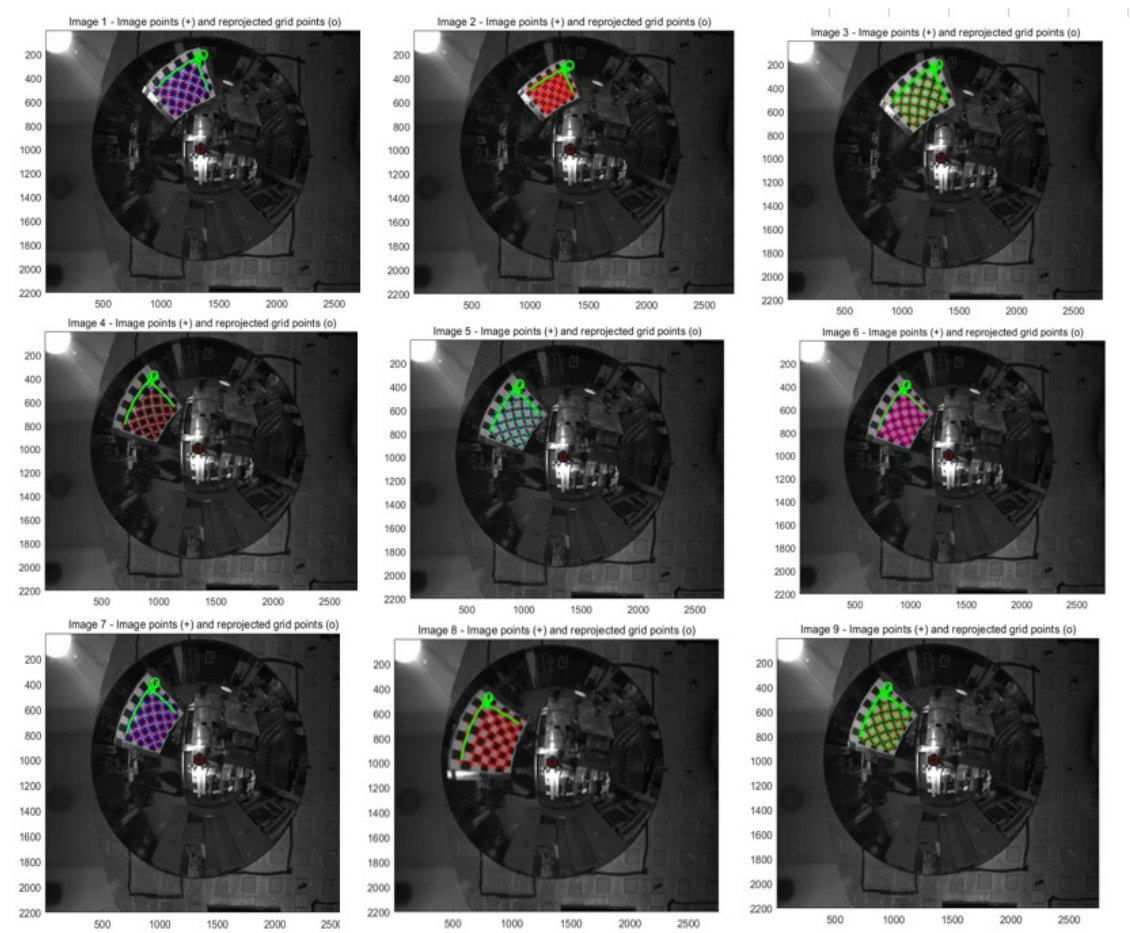
Figure 19. Reproject on